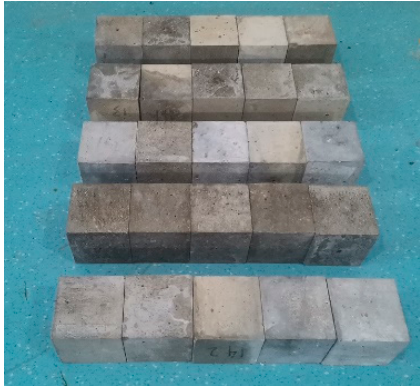
Figure 1. Concrete specimens eroded at different times.